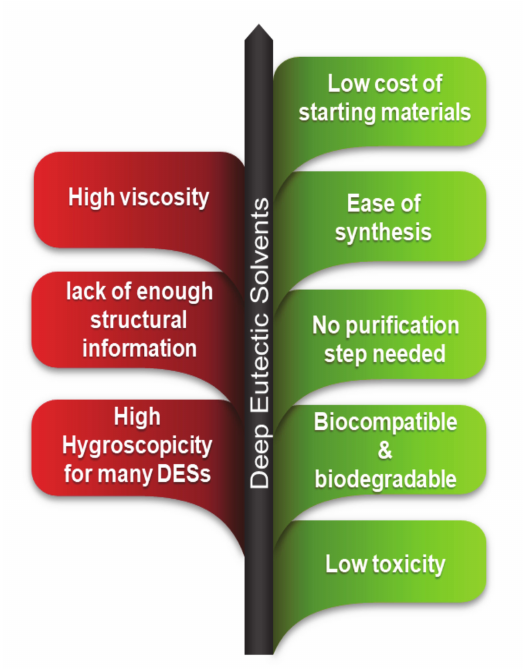
Figure 2. Merits and limitations of DESs as potential solvents